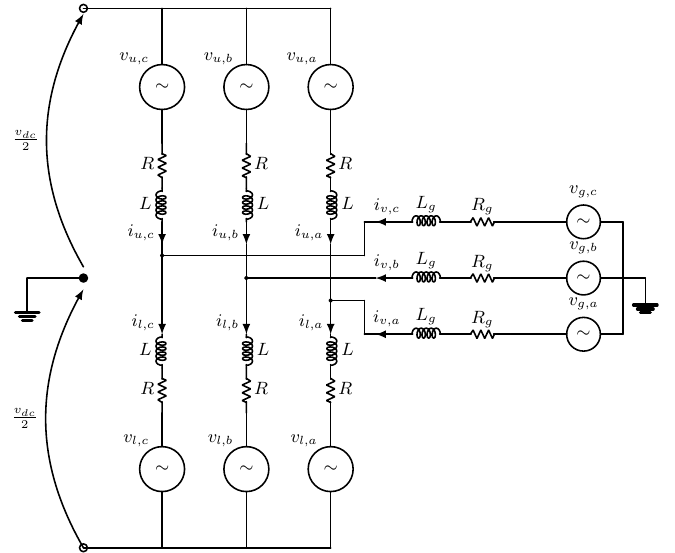
Figure 3. Arm Average Model (AAM) of an MMC-HVDC station connected to the electric grid in Grid Following